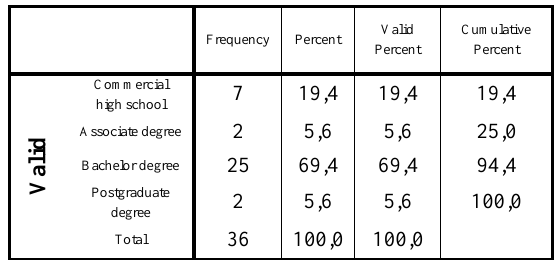
Table 5: Education Level (Education Status) of Accounting